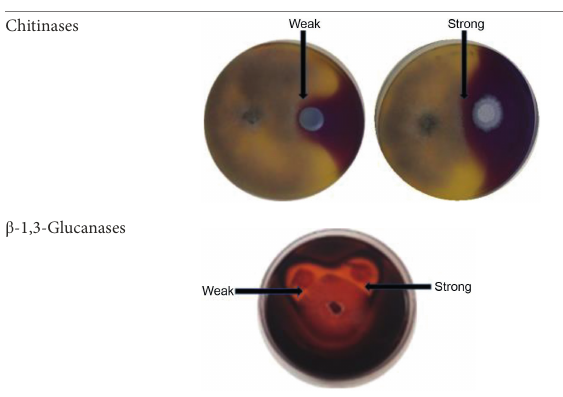
TABLE 1 Exemplar images of the chitinase and glucanase plate screening showing yeast and Botrytis cinerea growth, enzyme production and weak or strong inhibition